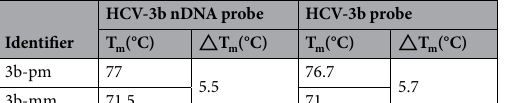
B-form structure, indicating the formation of a self-complementary hairpin structure 9,28 . The transition of duplex (Fig. 2b), the position and shape of the CD spectra were similar to those in 100 mM BTP buffer. The amplitudes of HCV-3b probe/3b-pm and HCV-3b nDNA probe/3b-pm duplexes were higher than that of single-stranded oligomers. The CD results of our study indicated that buffer concentration and methylated nucleotides on the partially neutralized probe could not significantly influence the formation of secondary structures in the duplex. Similar to previously reported CD results 9 , the effect of ionic strength on the formation of duplex structures for partially neutralized and regular DNA was also not observed in their study. DNA strands will separate at T m , and the temperature depends on several factors: the length of the molecule, sequence, solvent conditions, concentration of nucleic acid, and nucleic acid analog structure 30 . As shown in Table 2, in 100 mM BTP buffer, the melting temperature of HCV-3b nDNA probe/3b-pm (77 °C) was slightly higher than that of HCV-3b probe/3b-pm (76.7 °C). In 10 mM BTP buffer (shown in Table 3), HCV-3b nDNA gesting that the phosphate-methylated nucleotides on the probe backbone could reduce the electrostatic repulsion force between complementary strands. Other neutral DNA analogs, such as PNA or LNA, also exhibited incre- ments in melting temperature 30–32 . The backbone charge and conformation were important in the improvement